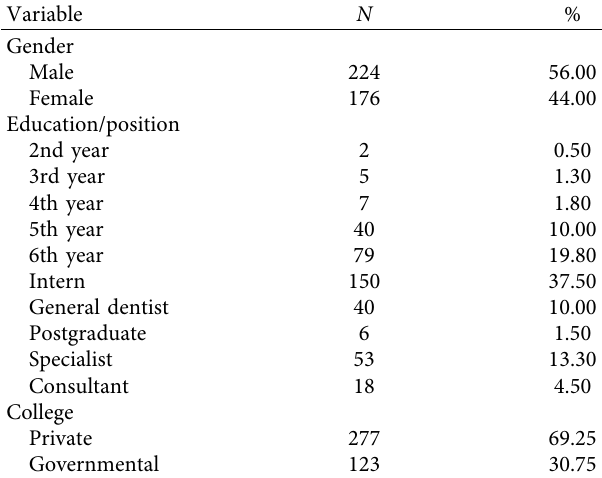
Table 2: Participant demographic